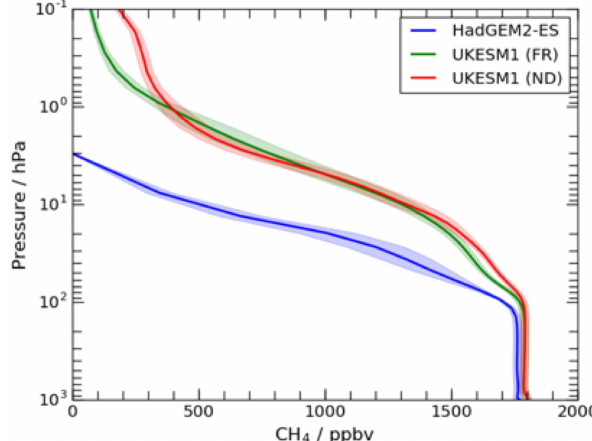
Figure 11. Vertical profiles of the mean tropical ( ± 10 ◦ N) mod- elled methane from multi-annual mean output from an atmosphere- only free-running simulation of HadGEM2-ES (OC14; blue), an atmosphere-only free-running FR (green) and nudged (ND; red) simulations of UKCA StratTrop in UKESM1 (this study). The shad- ing represents ± 1 standard deviation about the multi-annual